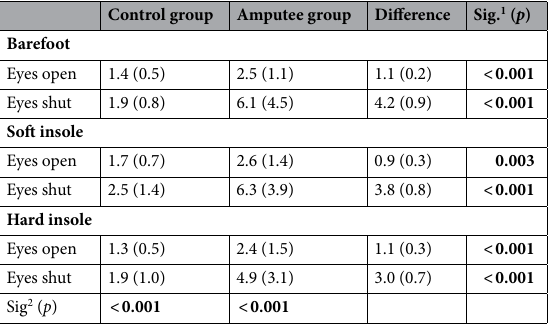
Table 7. Comparison of anterior velocity between experimental groups. Significant values are in [bold]. Mean (standard deviation). 1 Mann–Whitney Test. 2 Friedman Test. Anterior velocity (mm/sec).